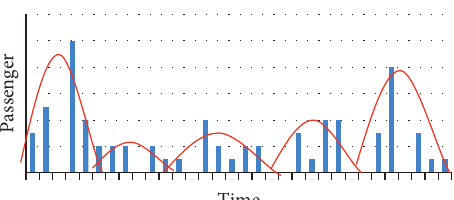
Figure 12: The normal distribution curve fitting of passenger flow distribution.